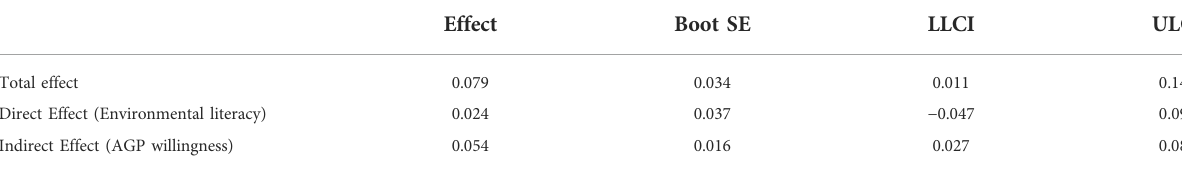
TABLE 10 The mediation effect of AGP willingness (Bootstrap